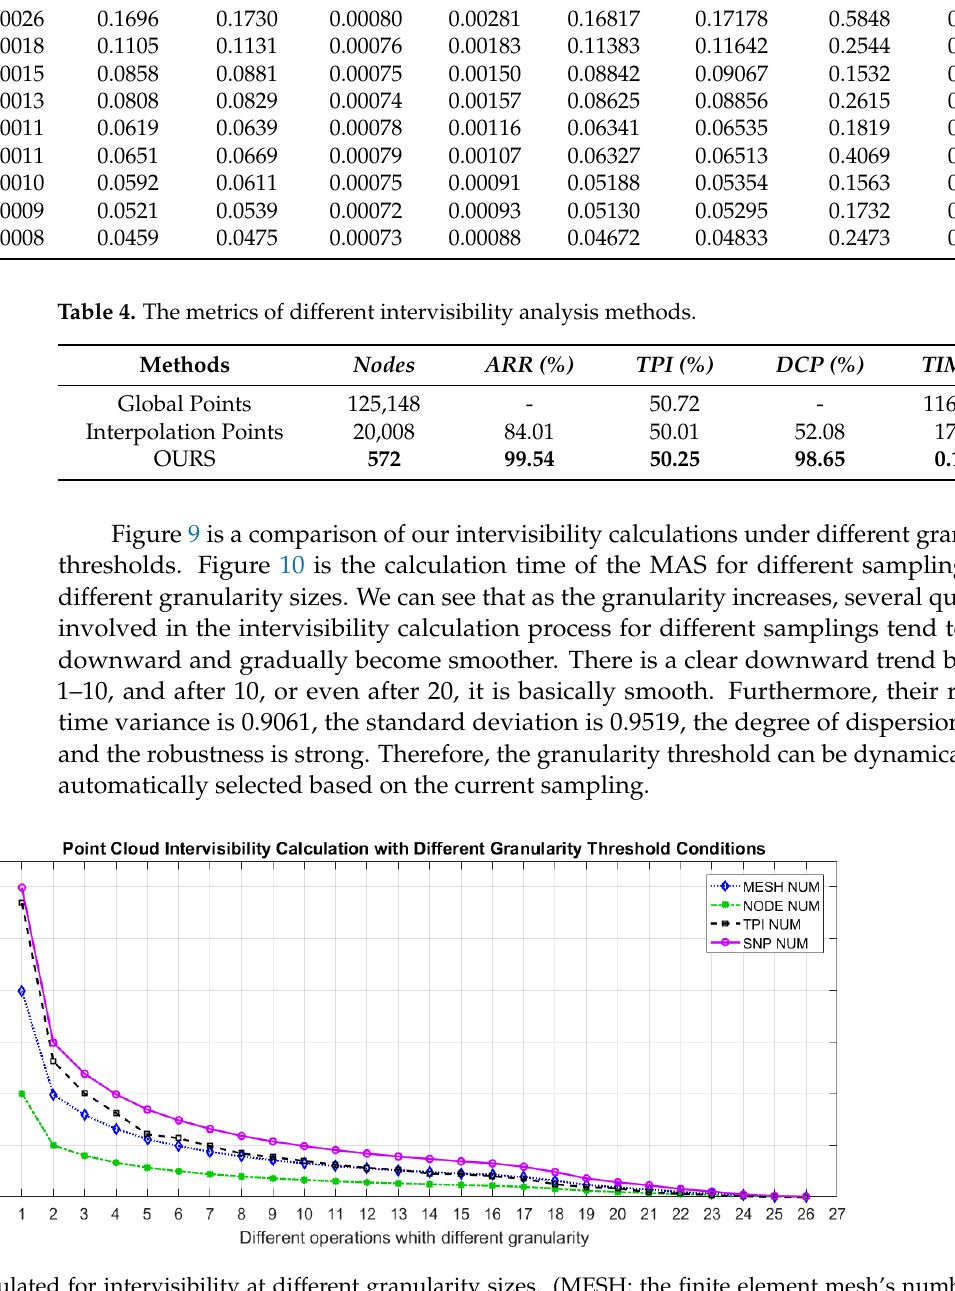
Figure 9. Values calculated for intervisibility at different granularity sizes. (MESH: the finite element mesh’s number; NODE: the nodes number in the finite element structure; TPI: the two-point intervisibility’s number; SNP: the nodes number of prediction judgments in the neighborhood of the subgraph.).